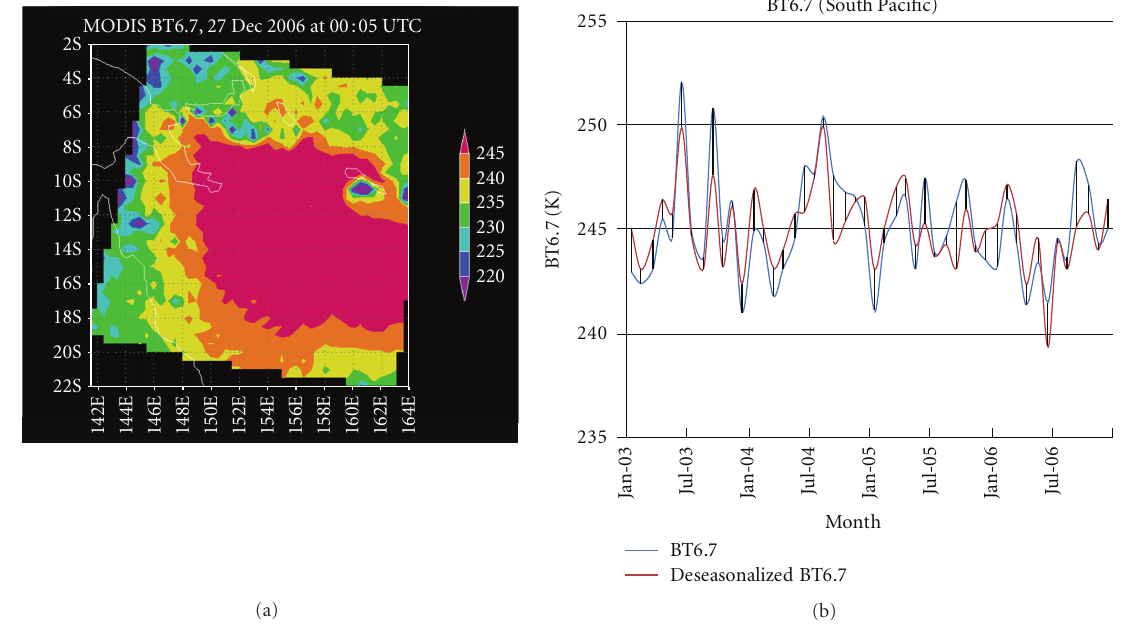
Figure 3: MODIS 6.7 μ m brightness temperature (BT6.7) distribution (a) and monthly variation (b) for the period from Jan 2003 to Dec 2006, showing the seasonality of this parameter in the South Pacific. The black vertical lines of the right figure represent the di ff erence between the monthly variation and the deseasonalized